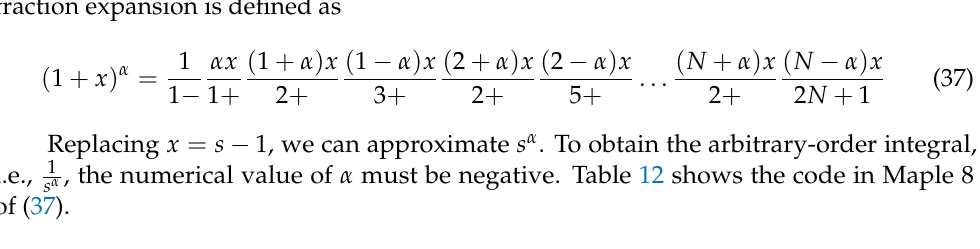
. ( a ) Magnitude response. s 0.5